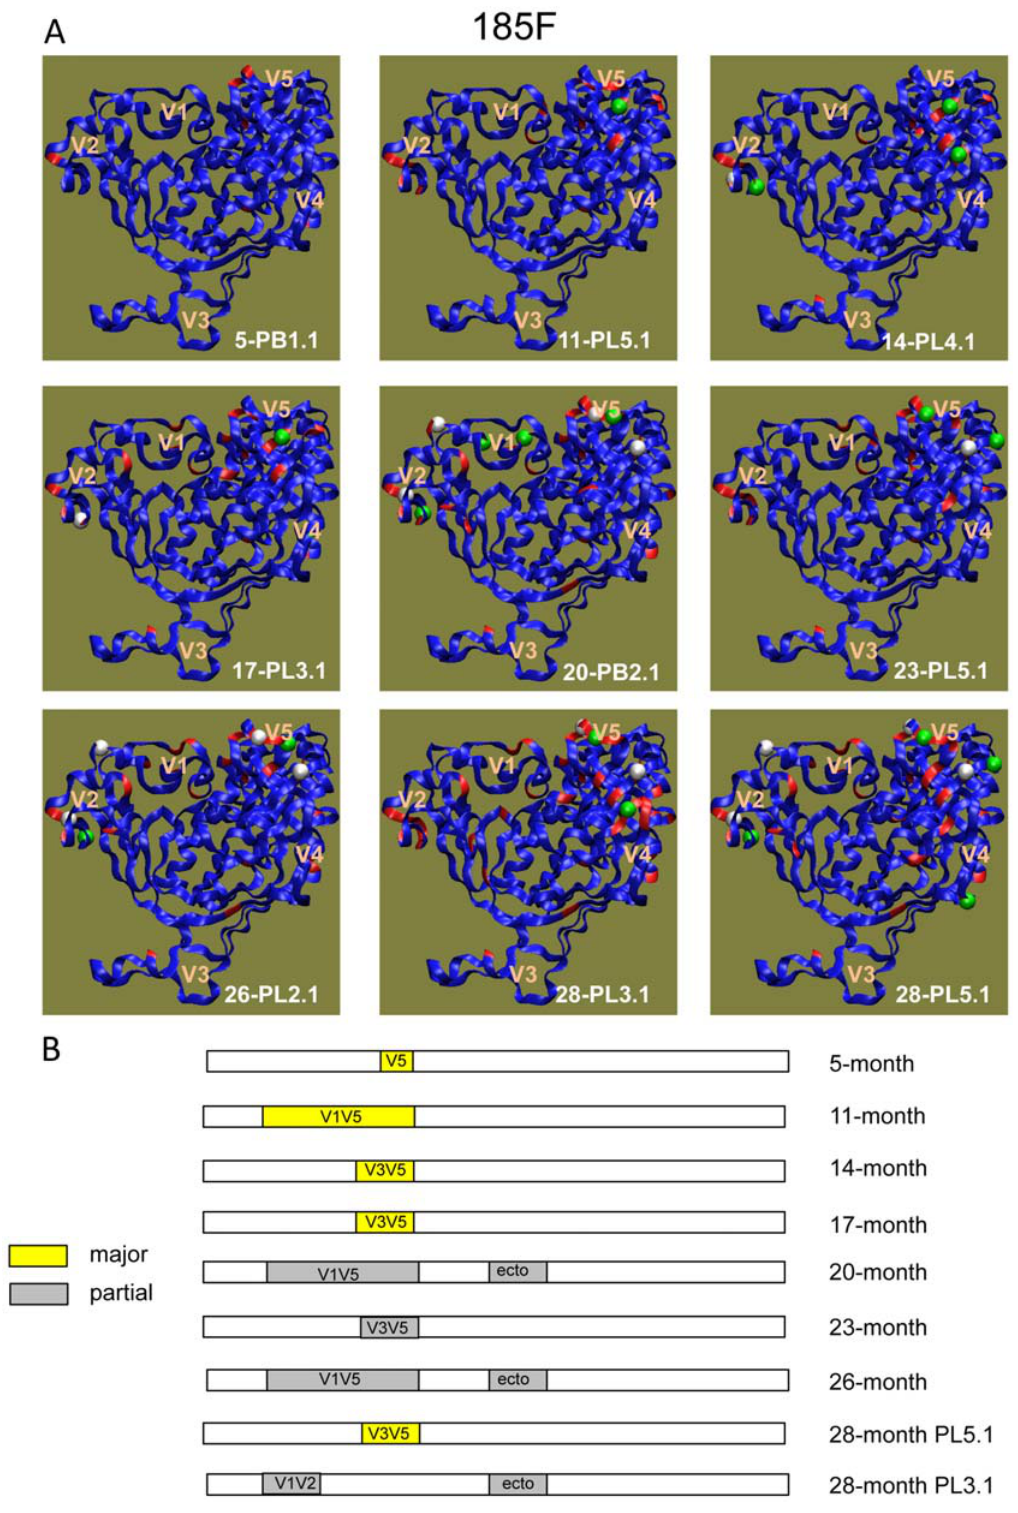
Figure 7. Nab escape in 185F involves multiple pathways. (A) A 3-dimensional representation of the gp120 amino acid sequence for a different longitudinal Nab escape variant Env is shown in each panel. The time point and clone is indicated in each panel. The blue gp120 backbones were generated by homology modeling of the 0-month Env sequence onto the CD4-liganded HIV-1 YU-2 gp120 structure [54], with modeled V1V2 and V3 loops as described previously [25]. Red indicates amino acid changes relative to the 0-month Env sequence. Spheres indicate changes in potential N-linked glycosylation sites (green=loss, white=gain). (B) Schematic representation of the Env domains contributing to Nab escape at each time point. Yellow indicates that a single domain had a major effect on Nab resistance; gray indicates that a particular domain contributed partially to Nab resistance. For more detail, see Fig. S4.